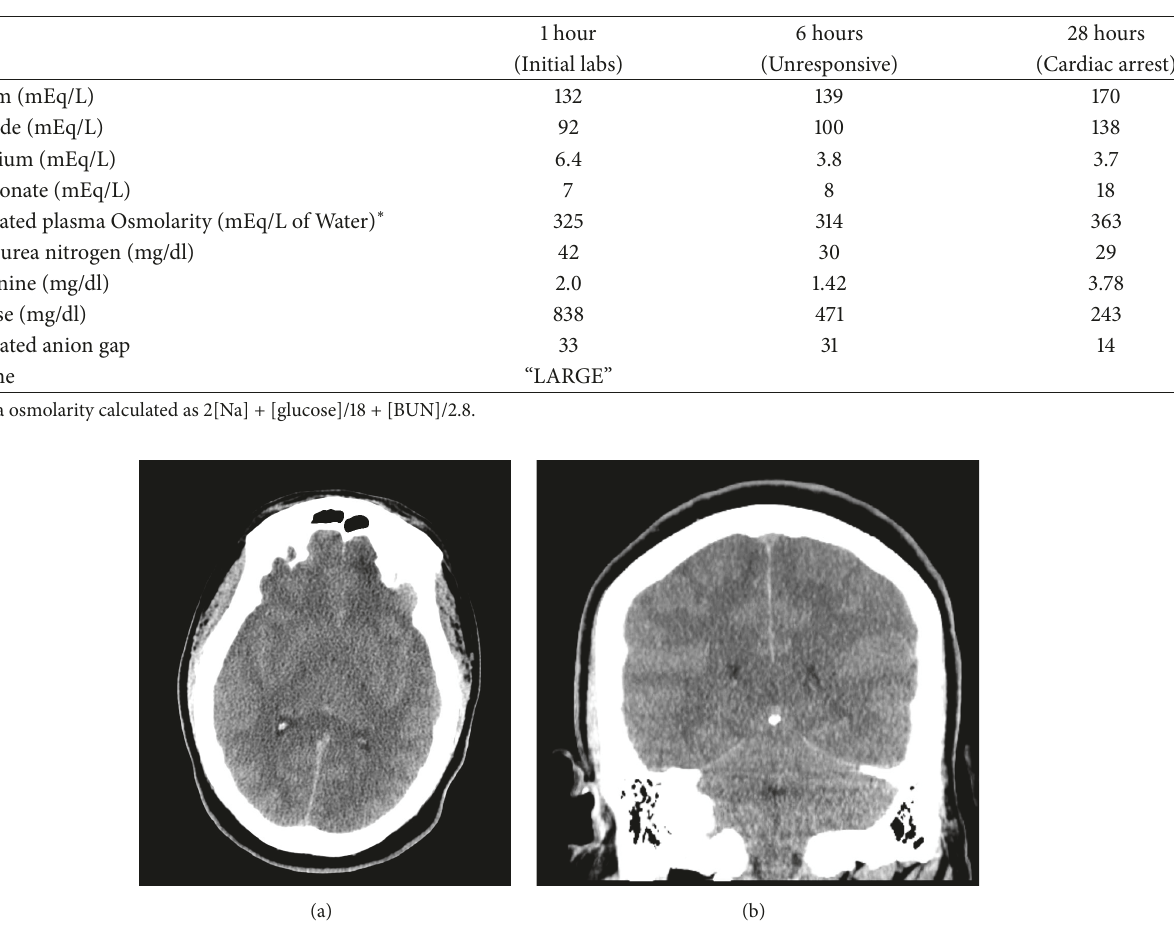
Figure 1: Axial cut (a) and coronal cut (b) of the noncontrast computed tomography (CT) of the head of the patient after becoming obtunded with nonreactive pupils. The images show diffuse cerebral edema with compression of lateral ventricles, effacement of the sulci, and obliteration of the perimesencephalic